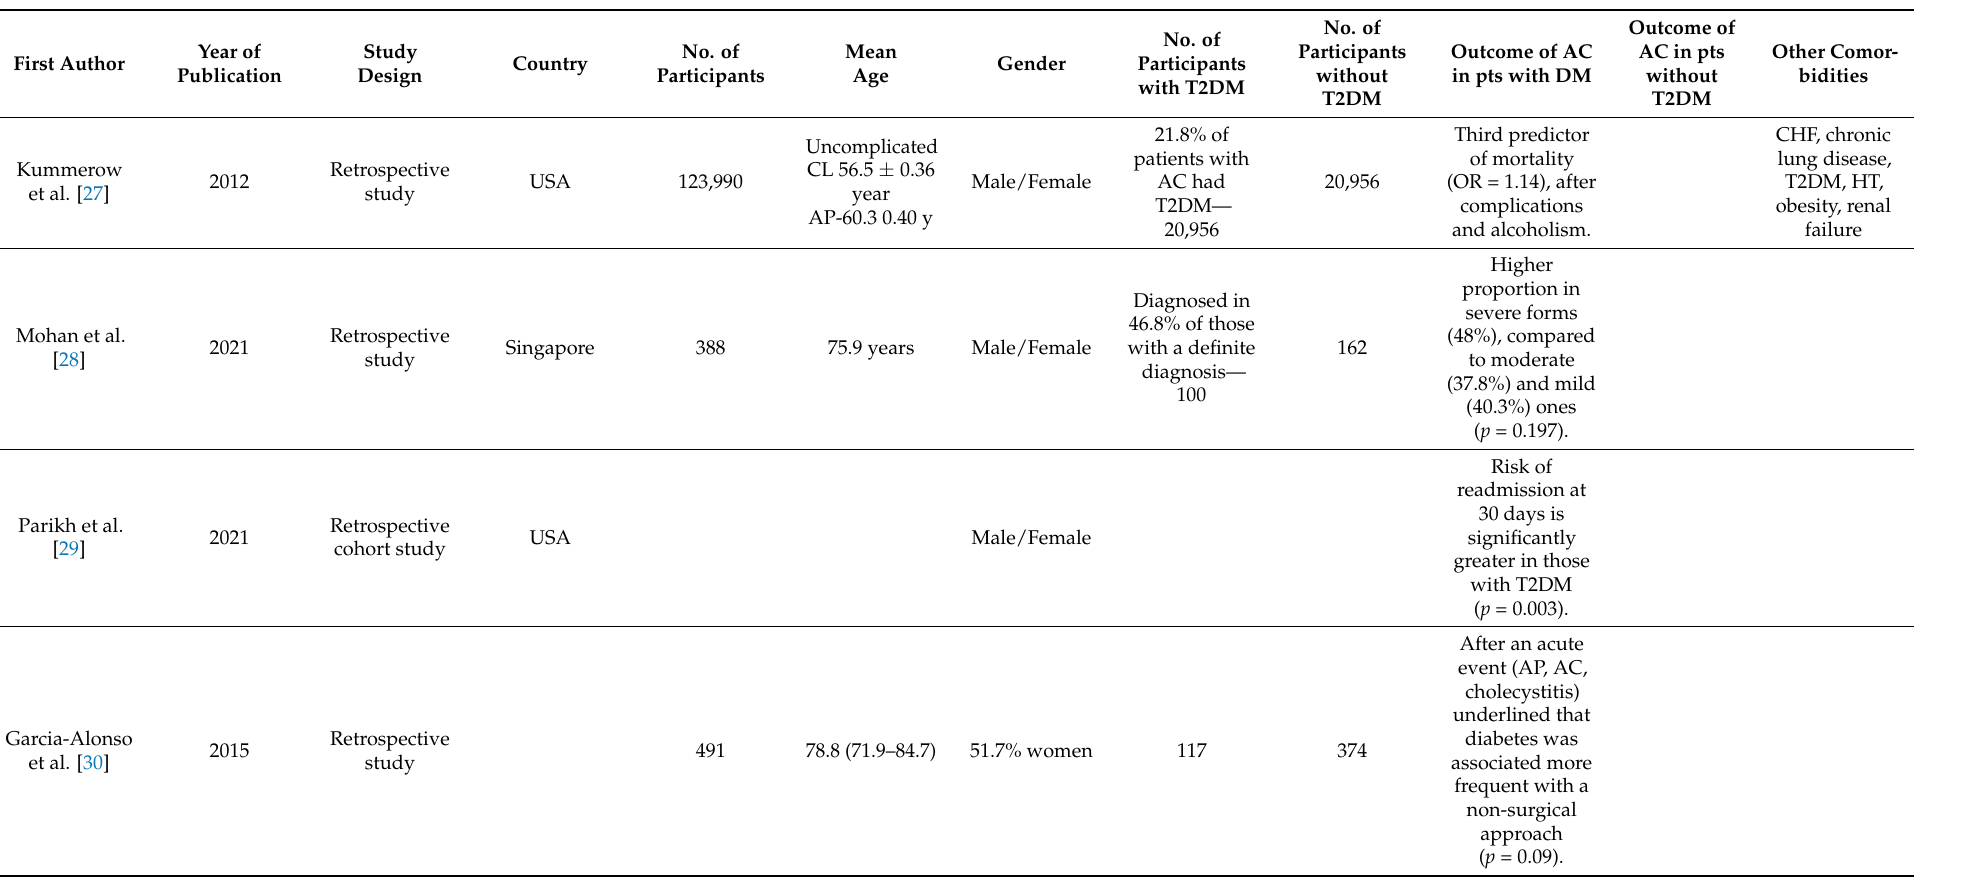
Table 1. Main particularities identified in diabetic patients suffering from acute cholangitis. AC—acute cholangitis, T2DM—type 2 diabetes mellitus,